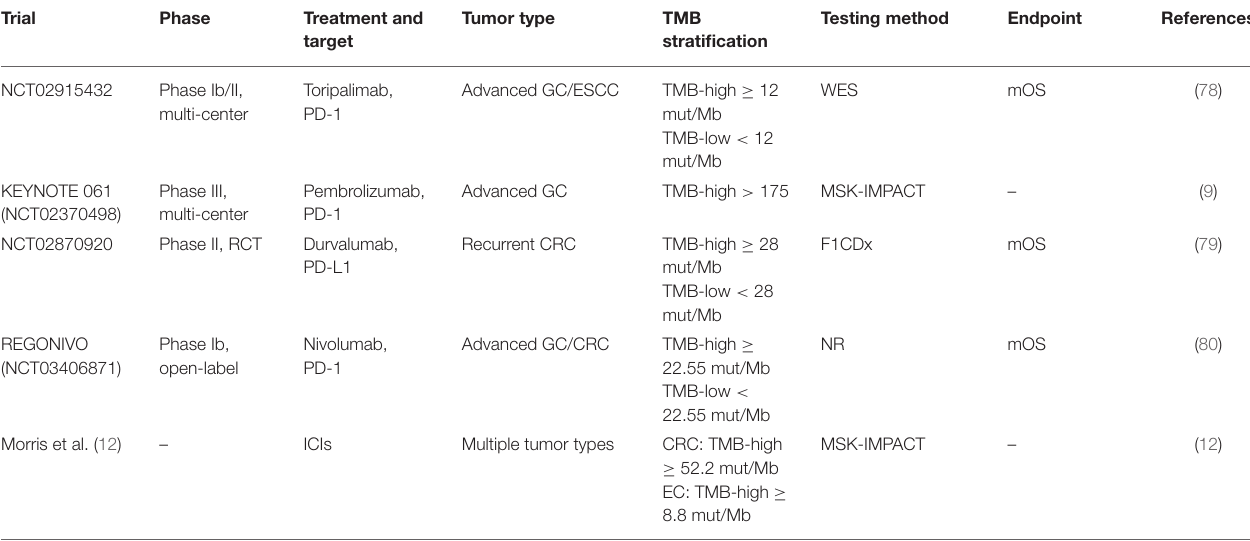
TABLE 2 | The clinical trials when TMB as a